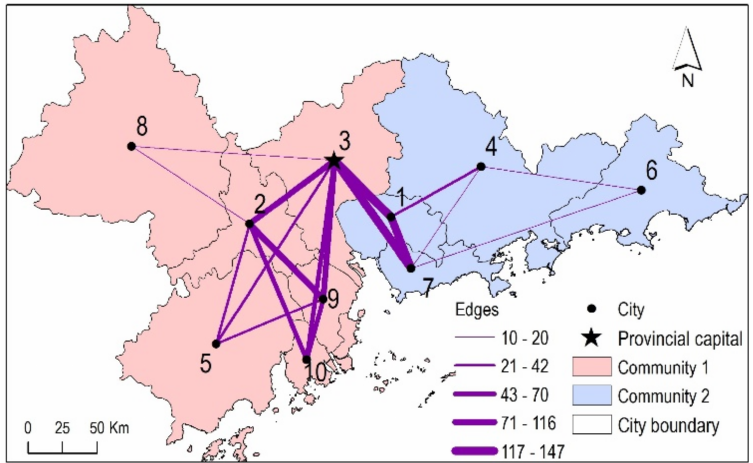
Figure 1. A sample spatial network and its structural